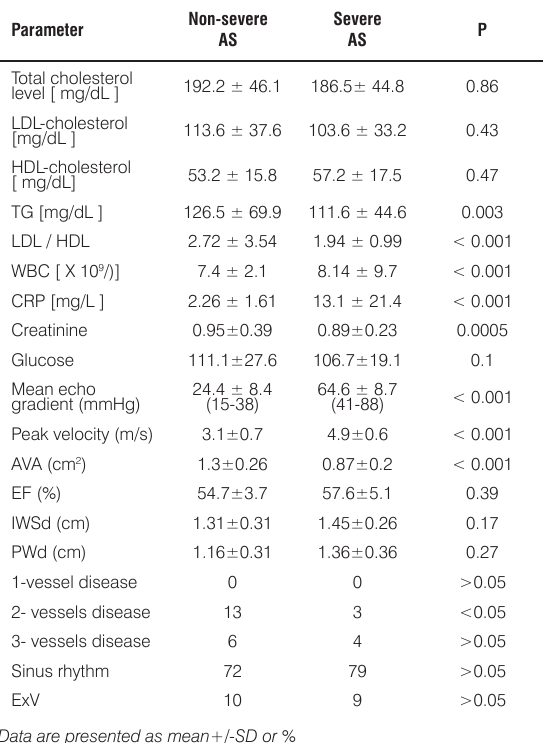
Table 2. Results of laboratory tests, echocardiography, coronary arteriography and electrocardiography findings. Abbreviations see in the main text.